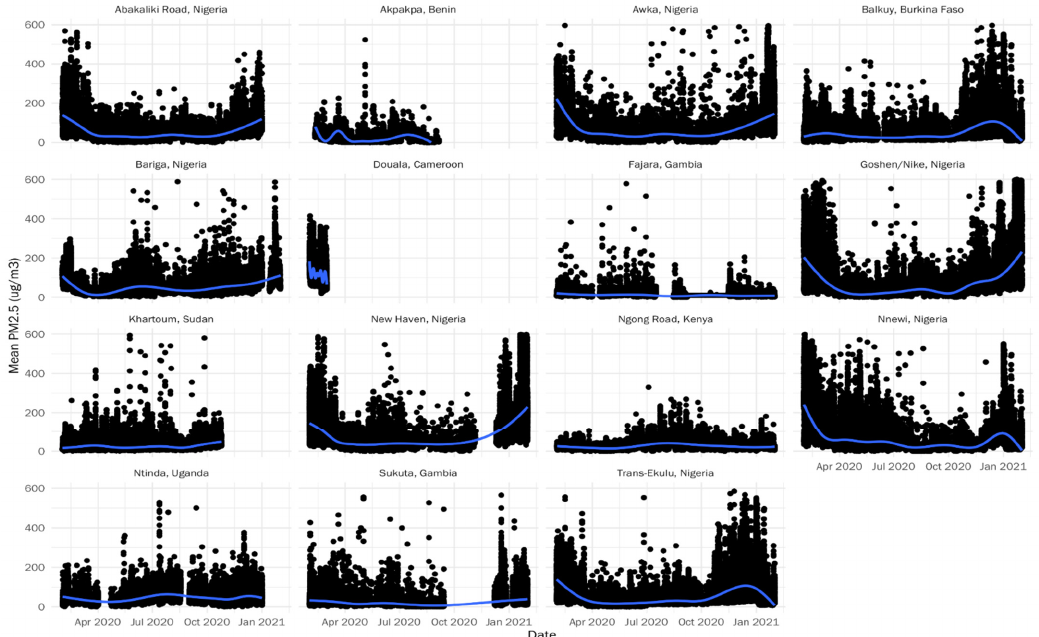
Figure 3. Five-minute periods mean concentrations for each site over the measurement period. Smoothed blue line depicts PM 2.5 average trend over time.